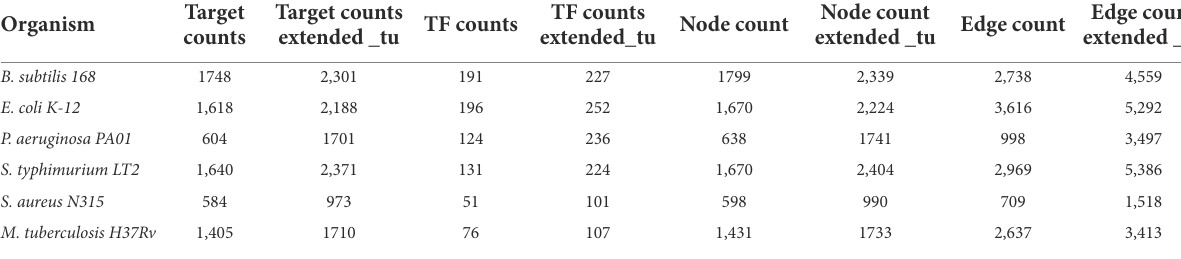
TABLE 4 Comparisons between experimentally and inferred GRNs.